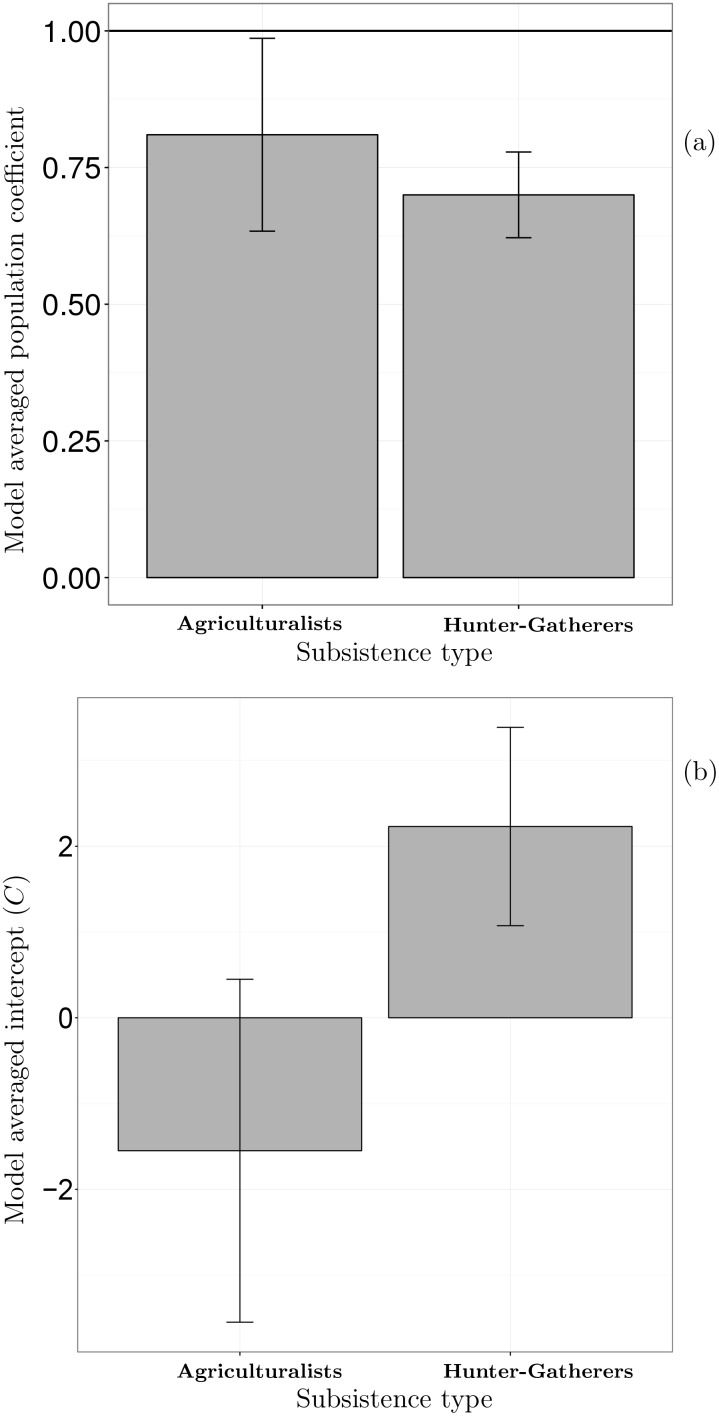
Model averaged population coefficients and intercepts from regression Eqs 7 and 9 and the 95% confidence interval for each coefficient or intercept shown as error bars for each subsistence type.